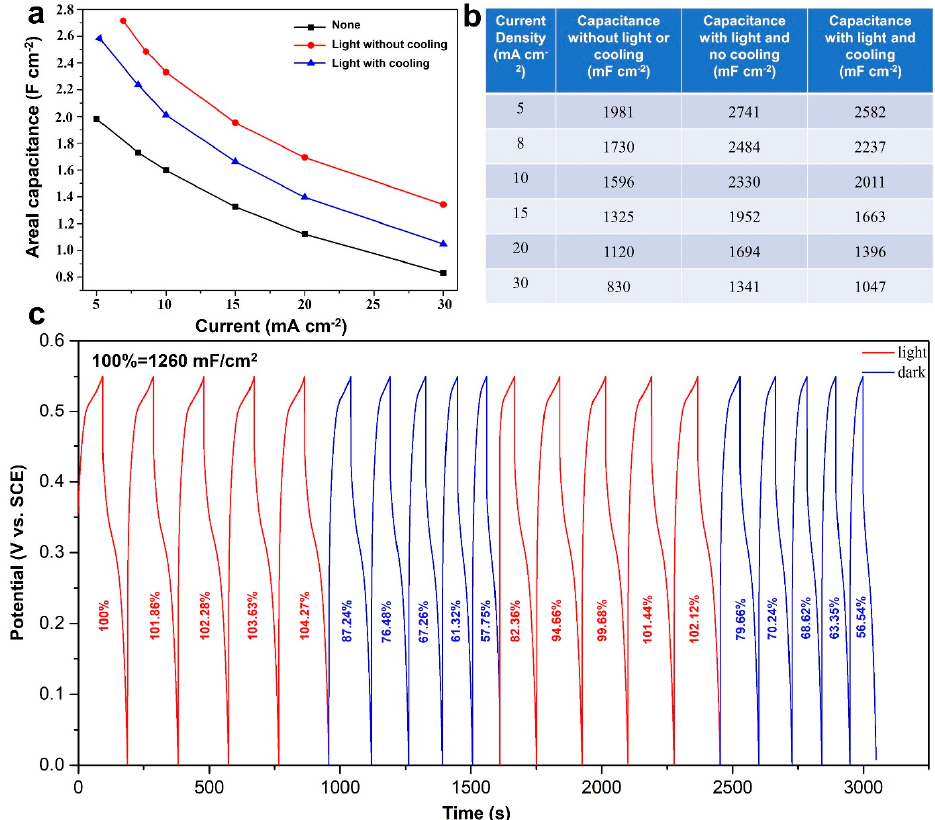
Figure 6. Areal capacitance calculated from various current densities ( a , b ) under the three testing cases, and GCD curves obtained at 25 mA cm − 2 under a switched light on/off mode with cooling water ( c ) of the CF@ZnCuNiO x NAs. water ( c ) of the CF@ZnCuNiO x